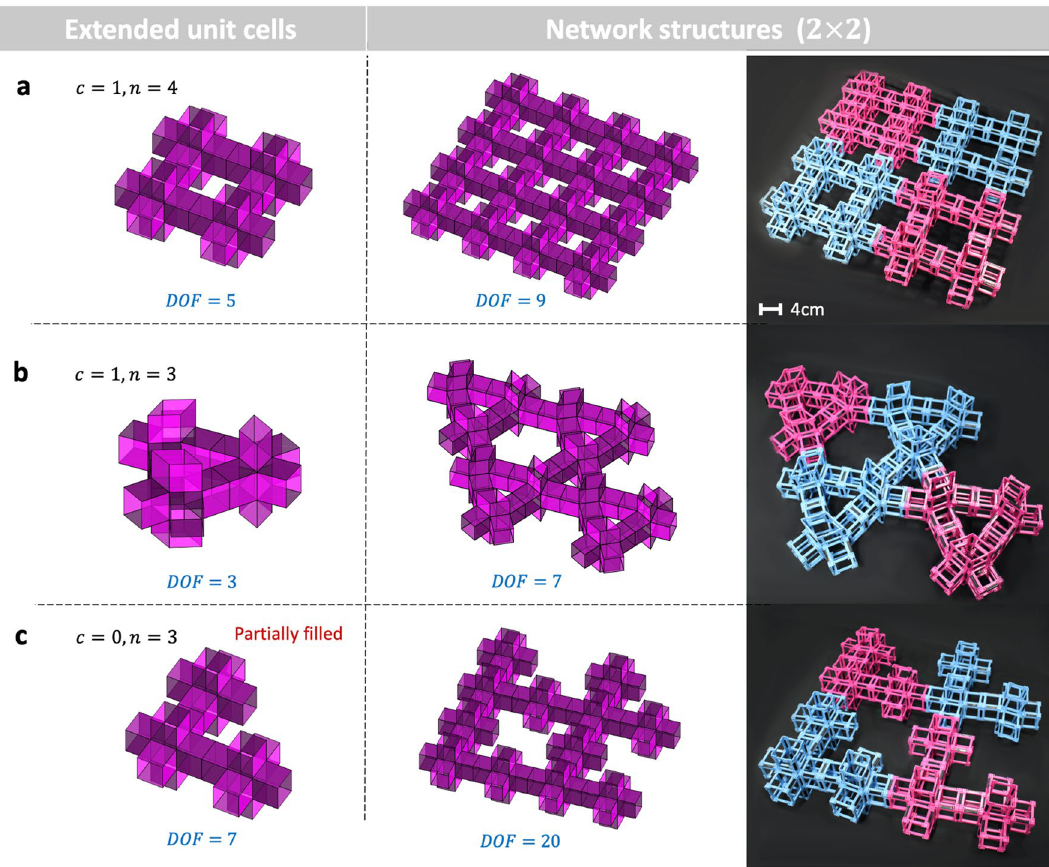
Figure 2. 2D extended unit cells and network structures for 3 ≤ n ≤ 4 : ( a ) square closed-loop, ( b ) triangular closed-loop, and ( c ) no closed-loop structures; we describe the fabrication method of the prototypes in Section I of the Supplementary Information (SI). The MATLAB code for the computation of mobility of network structures is available in the